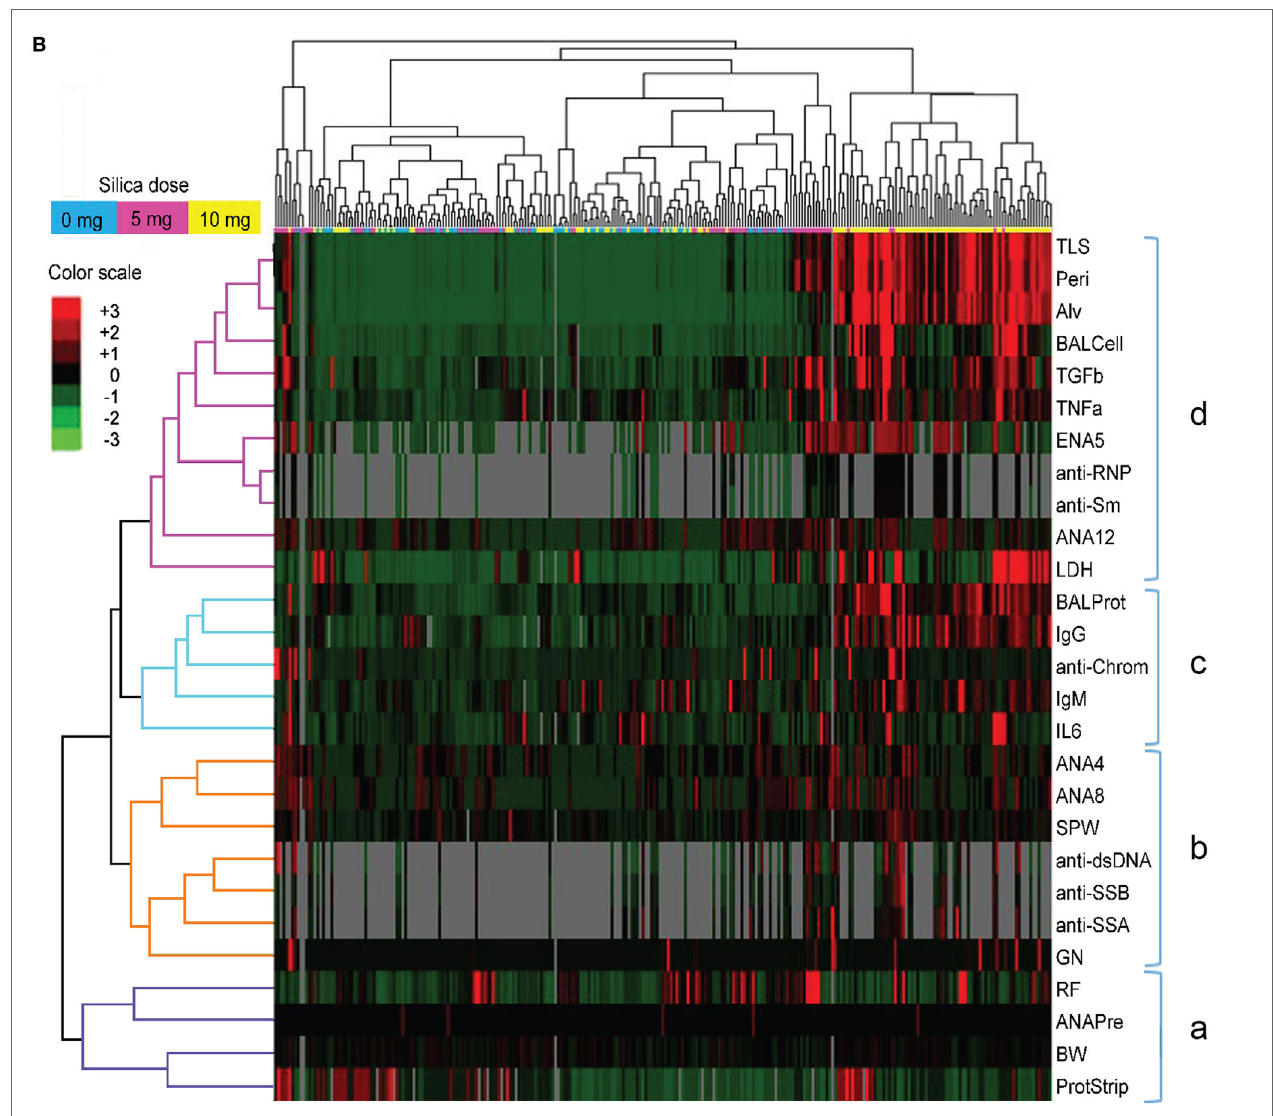
FigUre 5 | Correlations of biomarkers in silica-exposed diversity outbred mice. (a) Correlation matrix of Spearman’s correlation coefficient ( r s ) values for mice exposed transorally to 5 or 10 mg of crystalline silica. Spearman’s r s values were calculated using pairwise deletion and represented by a color gradient scale with red = 1, yellow = 0, and green = − 1. (B) Hierarchical cluster analysis of phenotypes and samples using a complete linkage clustering method and Spearman Rank Correlation as the similarity metric. Values are reported as relative change from the average of all samples for each phenotype with red = positive relative change, black = no difference, green = negative relative change, and gray = no data available. Dose groups are indicated by the color bar below the sample cluster with blue = 0 mg, purple = 5 mg, and yellow = 10 mg. Separate clusters are defined by a, b, c, and d. Abbreviations: TLS, total lung score; Peri, perivasculitis and peribronchitis; Alv, alveolitis; BALF cell, bronchial alveolar lavage fluid (BALF) total cell number; BALF Prot, BALF protein levels; LDH, lactate dehydrogenase (LDH) activity; SPW, spleen weight; ANA12, anti-nuclear antibody (ANA) score after 12 weeks of exposure; ENA5, designed for the detection of anti-Sm, -RNP, -SS-A (60 kDa and 52 kDa), -SS-B, and -Scl-70 IgG antibodies; RNP, anti-RNP IgG; Sm, anti-Sm IgG; SSA, anti-SSA IgG; SSB, anti-SSB IgG; dsDNA, anti-dsDNA IgG; Chrom, anti-chromatin IgG, ANA4, ANA score after 4 weeks of exposure; ANA8, ANA score after 8 weeks of exposure; ANAPre, ANA score before exposure; BW, body weight; GN, glomerulonephritis; ProtStrip, urine protein using ChemStrip